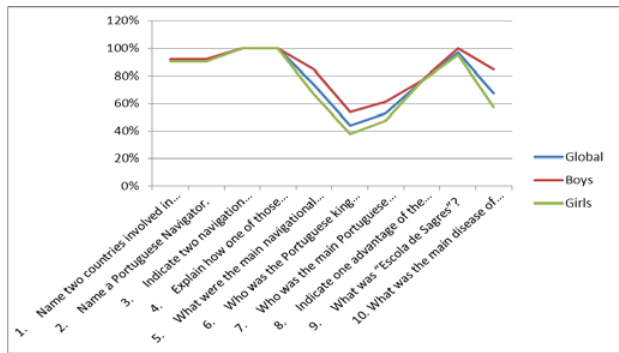
Figure 7. Pre-game knowledge test